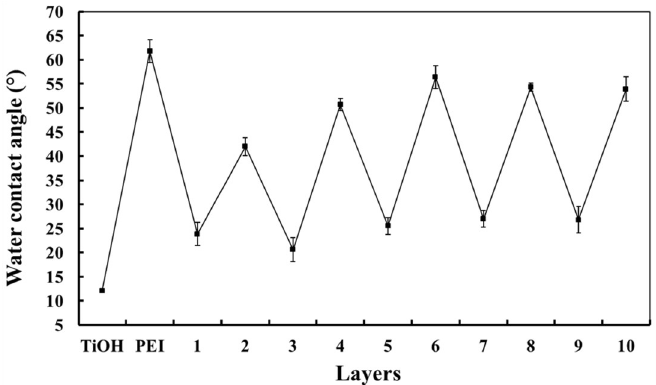
Figure 5. Water contact angles of the HA/QTC multilayer films. The odd numbers on the horizontal axis represent the film with HA as the outermost layer, and the even numbers represent the film with QTCs as the outermost layer.